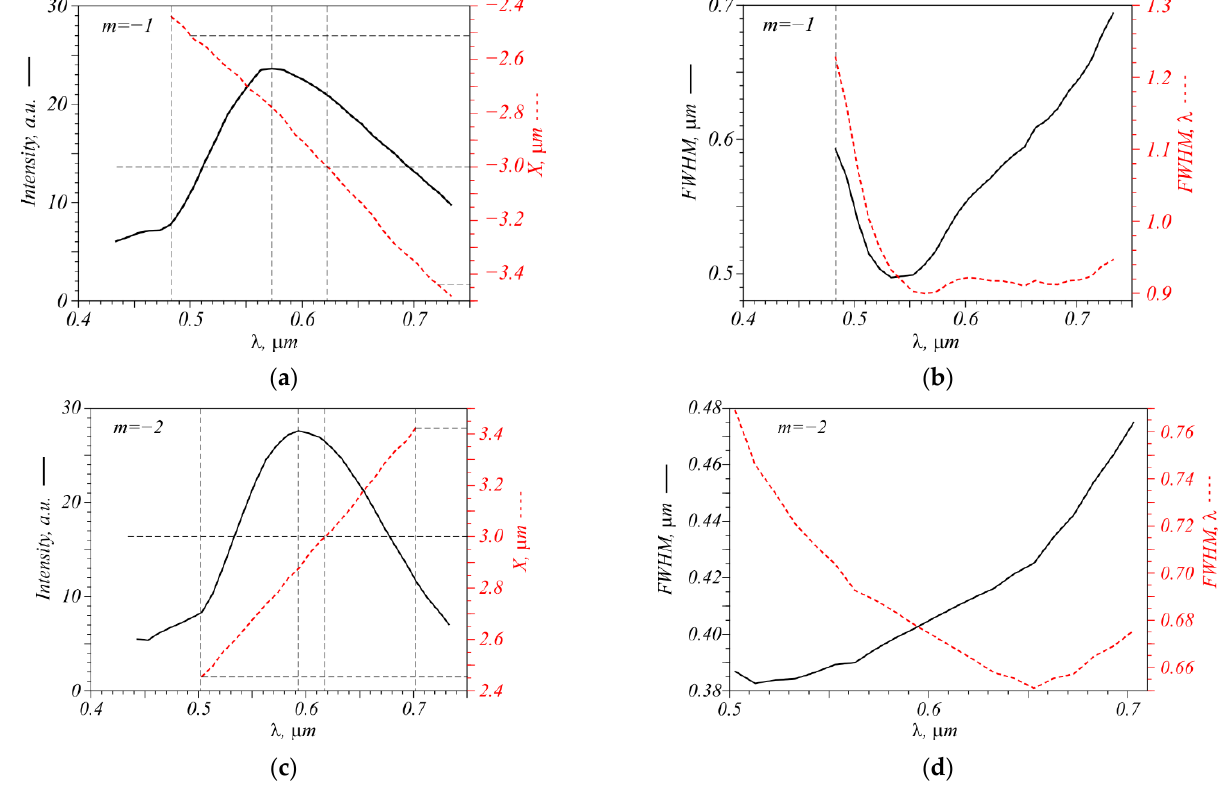
Figure 3. Dependences of the intensity, the X coordinate of the intensity maximum ( a , c ), and its width ( b , d ) on the light wavelength for the incident field with TC m = − 1 and m = − 2.